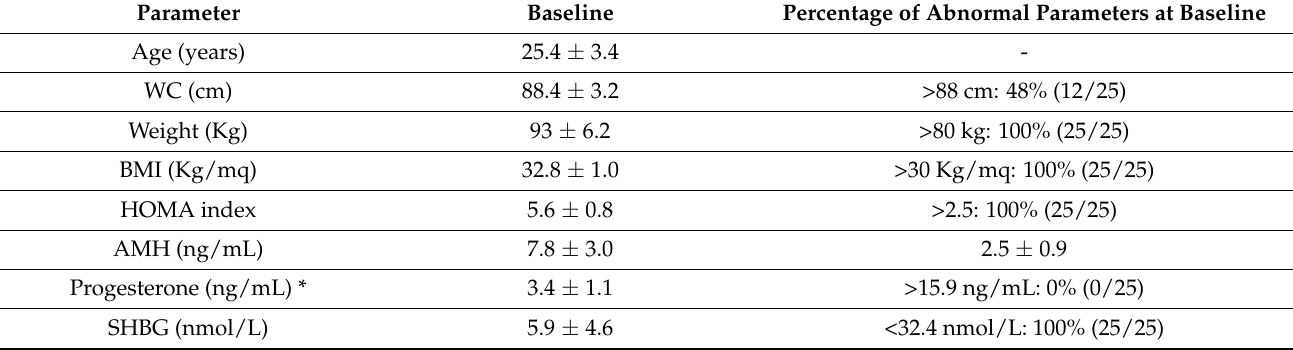
Table 2. Baseline parameters of the enrolled